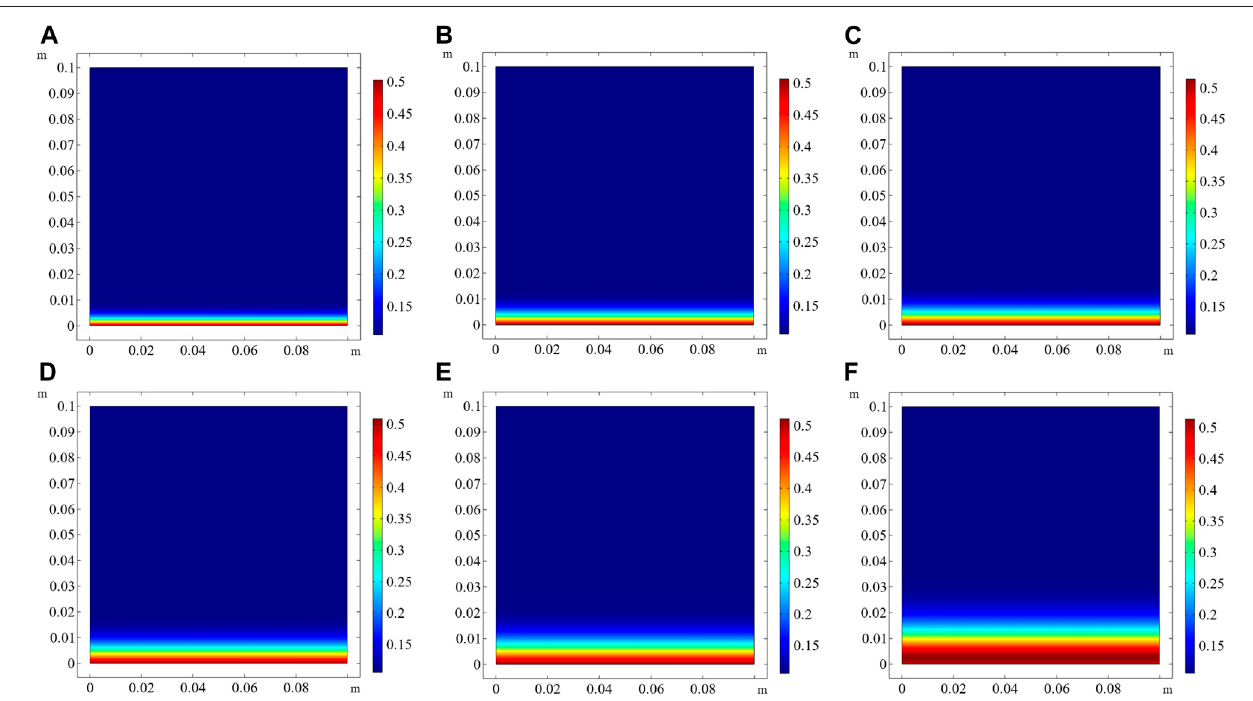
FIGURE4| Freechloride concentrationintheporesolutionofCAC atdifferentexposure times(unit:mol/Lofpore solution). (A) 30 days, (B) 60 days, (C) 90 days, (D) 120 days, (E) 180 days, (F) 360 days.